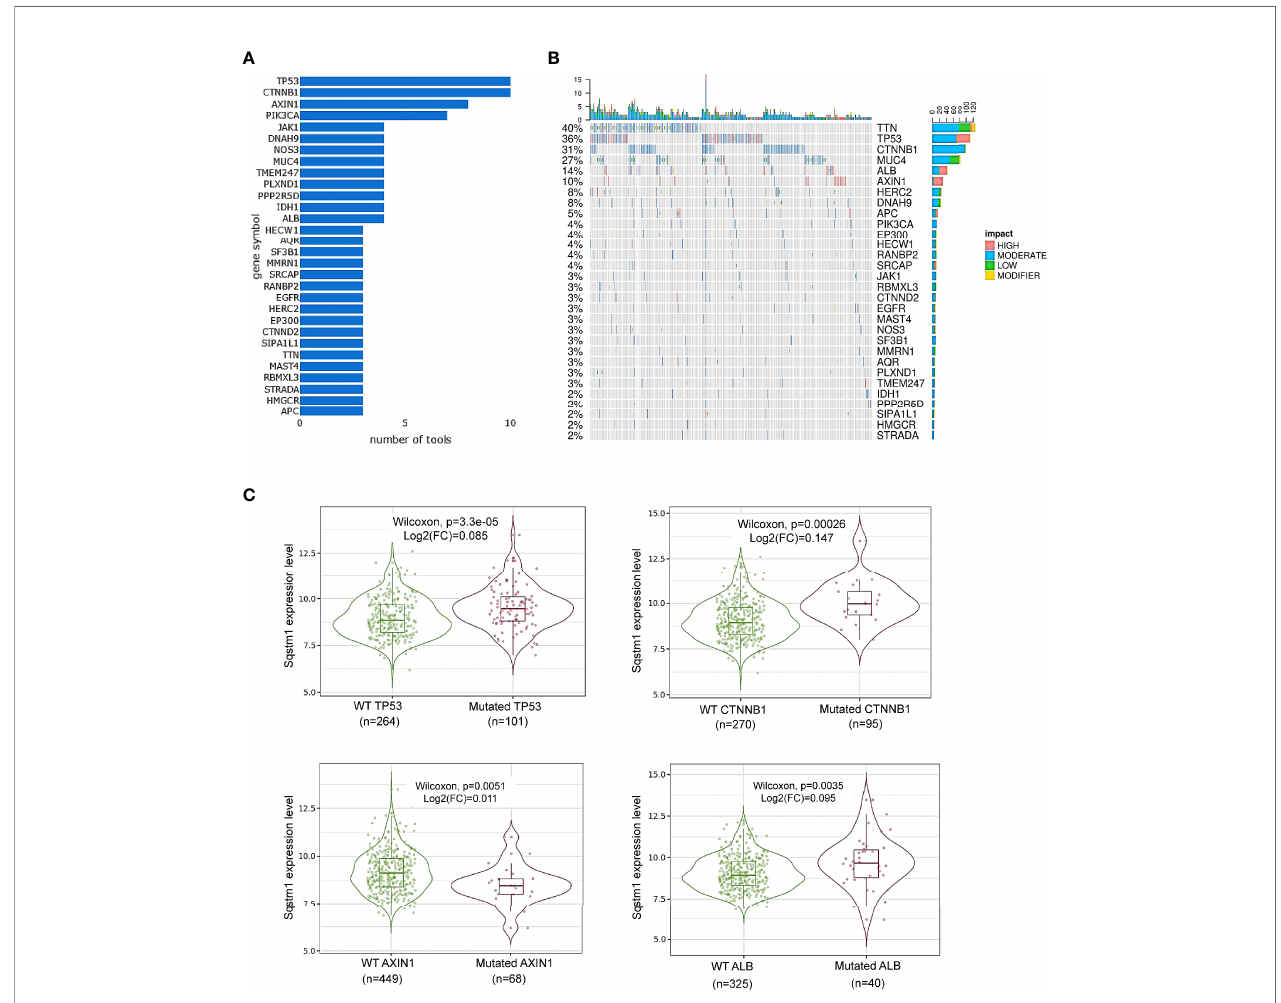
FIGURE 5 | Association of Sqstm1 expression level with gene mutation. (A, B) Top 30 genes that are mutated in LIHC. “ number of tools ” in (A) means the number of bioinformatic algorithms/tools were used to integrate multiomics to address the cancer driver events at distinct molecular levels (30). The percentage in (B) represents the total percentage of mutation in the samples for each mutated gene. The x-axis in (B) represents the samples from different LIHC patients. (C) Representative genes whose mutation is signi fi cantly associated with Sqstm1 expression in LIHC. (A, B) are the results from cBioportal, and (C) from TIMER2. FC, Fold change (the differential expression levels between samples with WT and mutated Sqstm1